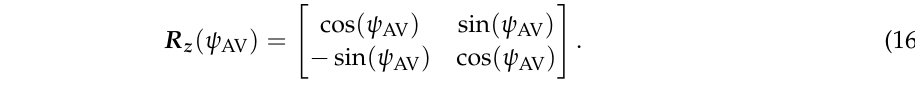
Algorithm 1: Post-processing of the mechanical imaging sonar data for target